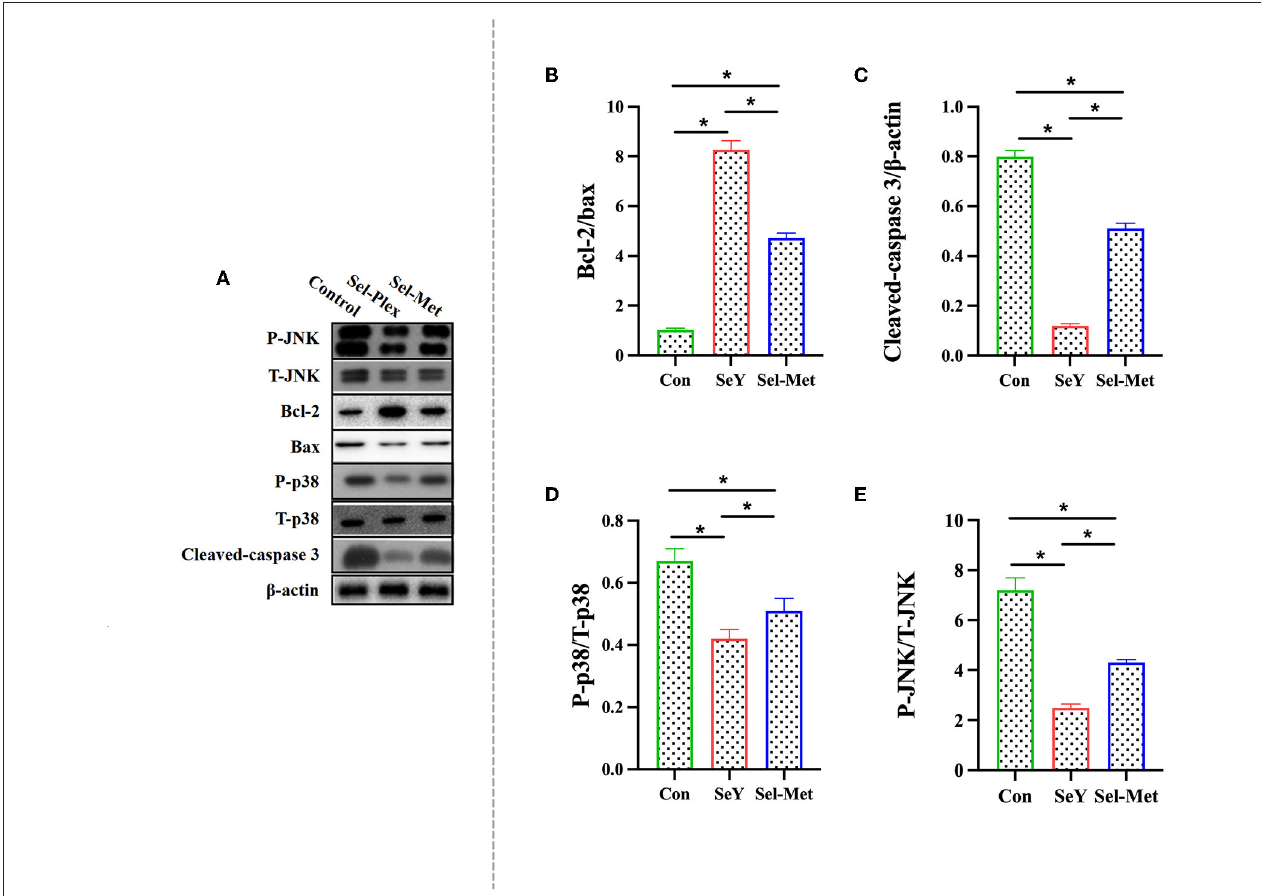
FIGURE 7 | Effects of SeY and Sel-Met supplementation on (A) is the original band of Western Blot, (B) Bcl-2/Bax, (C) Caspase-3, (D) P-p38/T-p38, and (E) P-JNK/T-JNK protein expression in PMECs. Cells were incubated for 24h with 0.6 ppm SeY and Sel-Met and then were collected for the determination of protein expression. Data are expressed as mean ± SEM ( n = 3). *Indicates that the difference was statistically significant ( P <